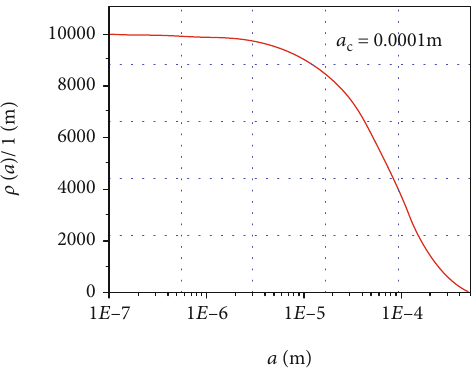
Figure 4: Probability density functions of the